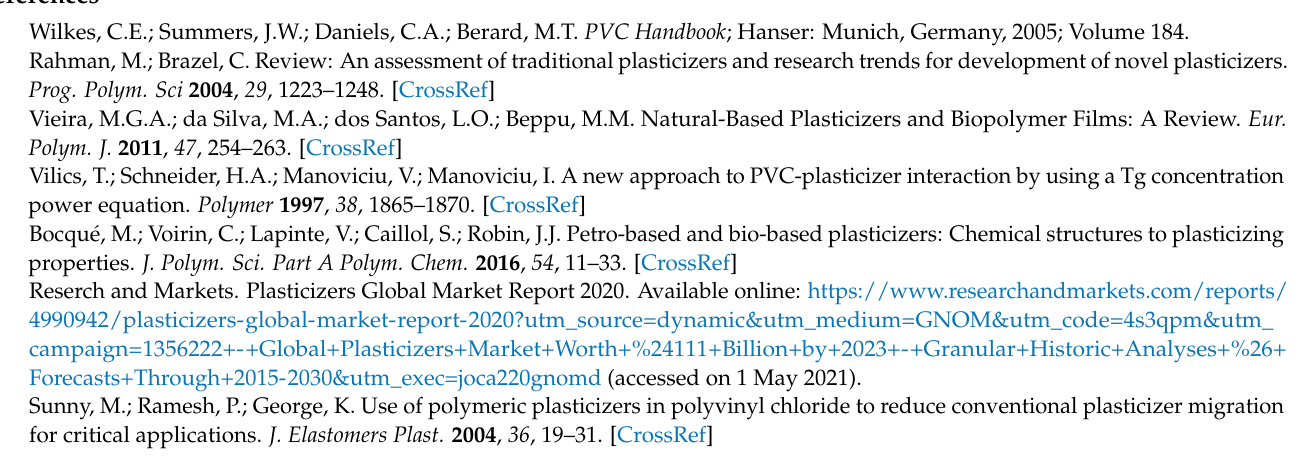
25; Table S5: GA-PLS Top 12 when molecular descriptors are screened to 13; Table S6: GA-SVR results under different numbers of descriptors; Table S7: GA-RFR results under different numbers of descriptors; Table S8: R 2 for different models on training set, cross-validation and test set; Table S9: SF projections for some potential